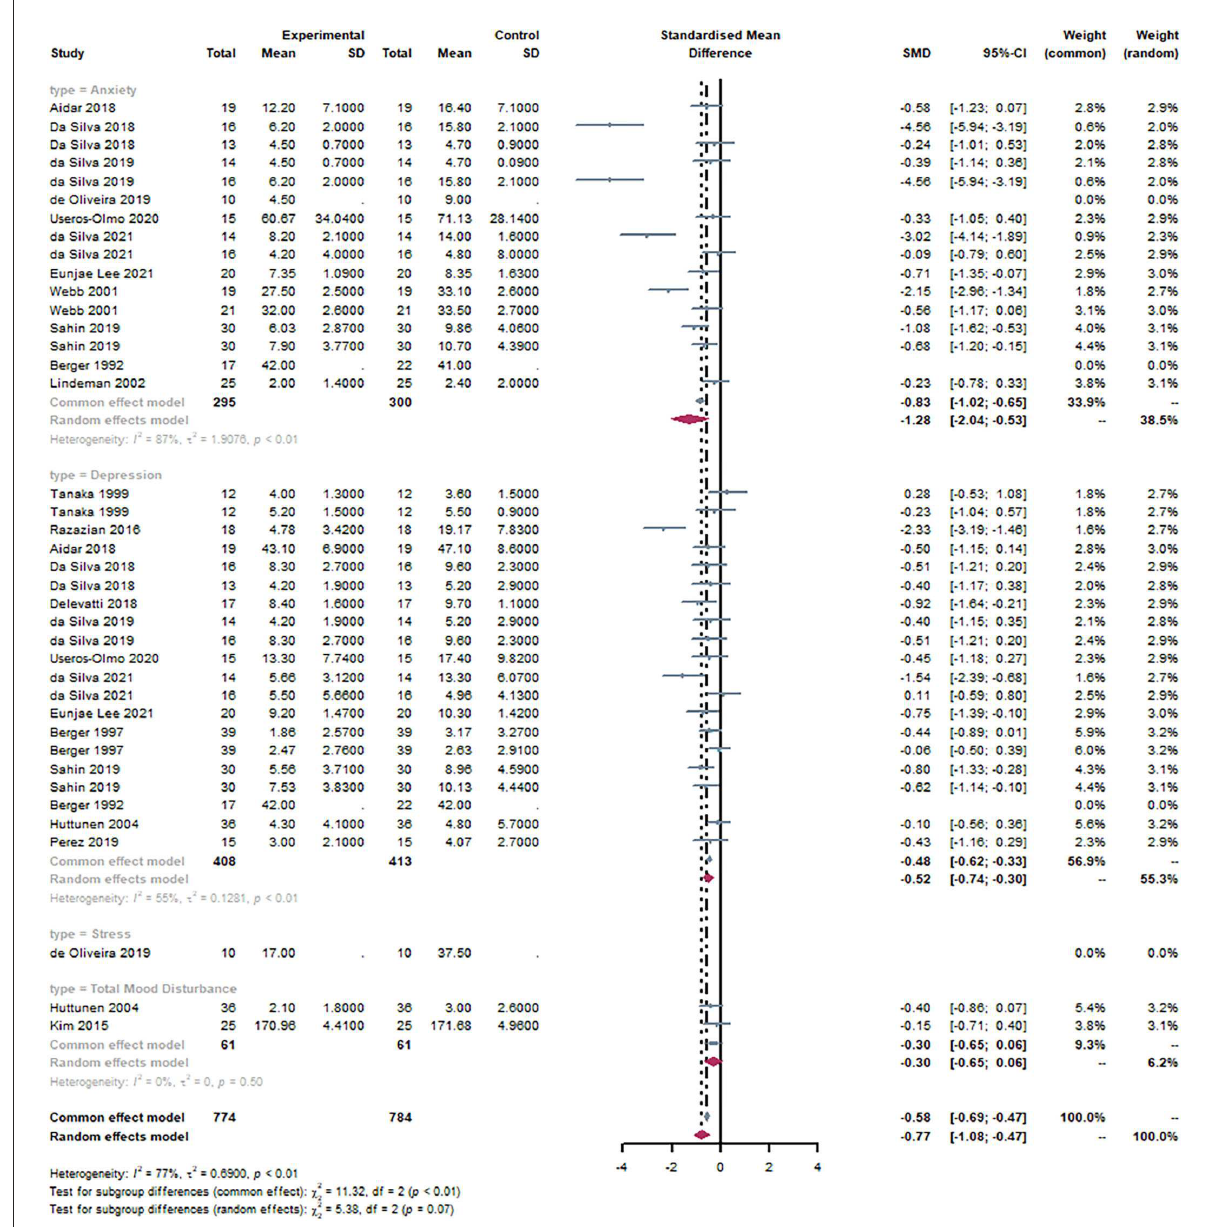
FIGURE8 Forest plot of the type of mental health. By subgroup analysis of the disease, Anxiety [SMD = − 1.28, 95% CI ( − 2.04, − 0.53), I 2 = 87%, P < 0.01] and Depression [SMD = − 0.52, 95% CI ( − 0.74, − 0.30), I 2 = 55%, P < 0.01] were statistically significant.